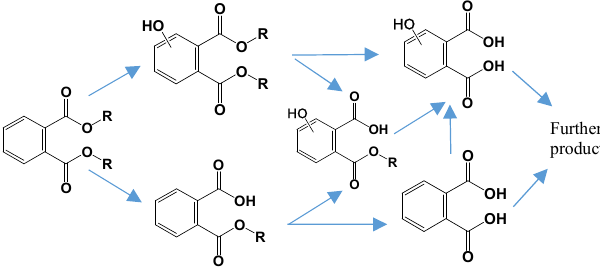
Figure 6. Possible degradation pathways of DMP and DEP.